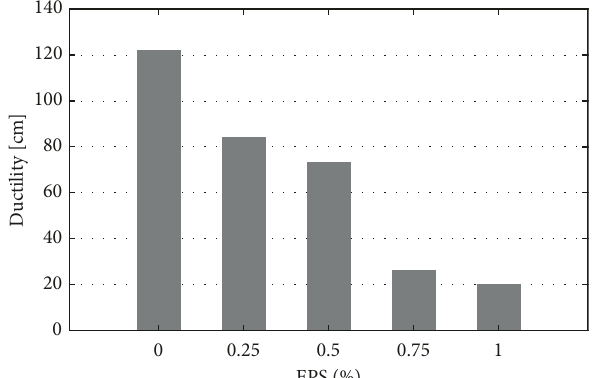
Figure 6: Variation of flash and fire point